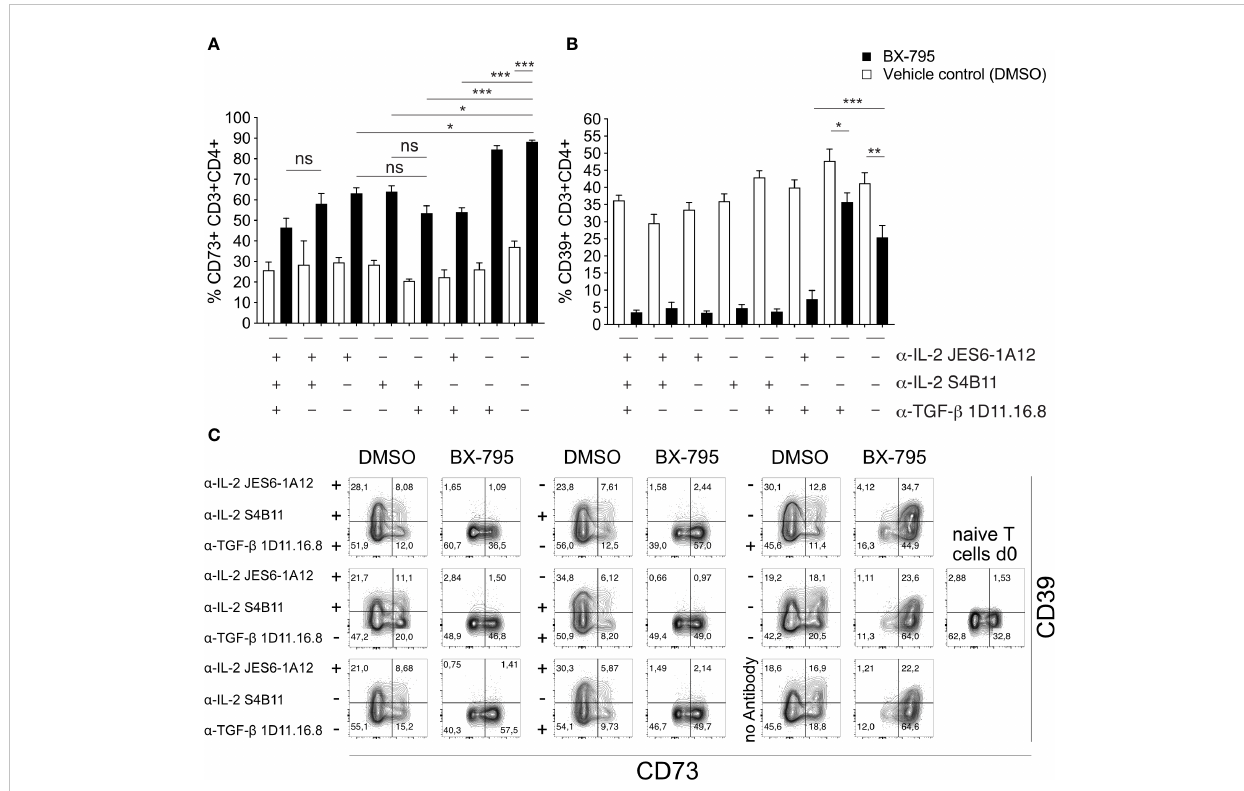
FIGURE 5 IL-2 secreted by Th-IL-2 cells is biologically active. (A, B) , bar graphs show the percentages of CD73 + (left panel) and CD39 + (right panel) CD3 + CD4 + T cells as determined by fl ow-cytometry for each indicated condition. Brie fl y, naïve CD4 + T cells [1x10 5 /well] from double transgenic allergy mice were co-cultured with BMDCs [2x10 4 /well] and recombinant Art v 1 protein [1 µg/mL] in the presence or absence of BX-795 [0.24 µM]. Blocking- antibodies against IL-2 and/or TGF- b were added at the beginning of the 120 h incubation period at a fi nal concentration of 10 µg/mL in combinations as indicated. Presence of the respective blocking antibody is indicated by a “ + ” , replacement of the antibody by its isotype control at a concentration of 10 µg/mL is indicated by a “ - ” . After 120 hours, cells were stained with fl uorophore-conjugated antibodies and analyzed by fl ow- cytometry. (C) , Representative FACS plots of the experiments performed in (A, B) are shown. Numbers indicate percent cells in the respective quadrants. The presence or absence of blocking antibodies is indicated on the left-hand side of each set of contour plots. Data show (A, B) , mean values ± SEM of three independently performed experiments. (A, B) , one-way ANOVA with Tukey ’ s post-hoc analysis comparing each condition with each other. The p-values are indicated by *, p < 0.05; **, p < 0.01; ***, p < 0.001. ns, non-signi fi